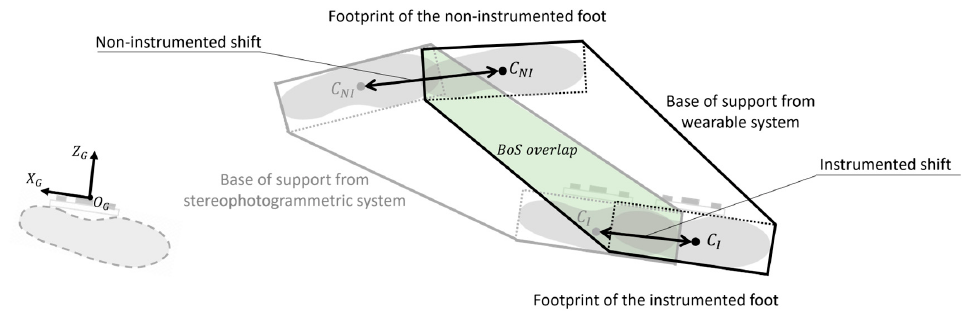
Figure 12. Metrics to describe the base of support estimation. In this example the instrumented base of support areas from the wearable system (black) and stereophotogrammetric system (grey) are illustrated. The base of support overlap (green) is defined as the percentage of the total base of support area shared by sensor-based area and the one obtained from the stereophotogrammetric system. Instrumented and non-instrumented shifts are the distances between footprints’ centroids of instrumented ( C I ) and non-instrumented foot ( C NI ) calculated with the wearable system and the stereophotogrammetric system.